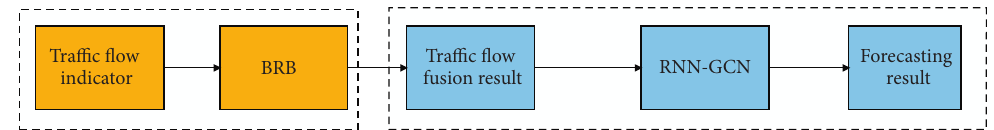
Figure 1: Traffic flow forecasting implementation process.